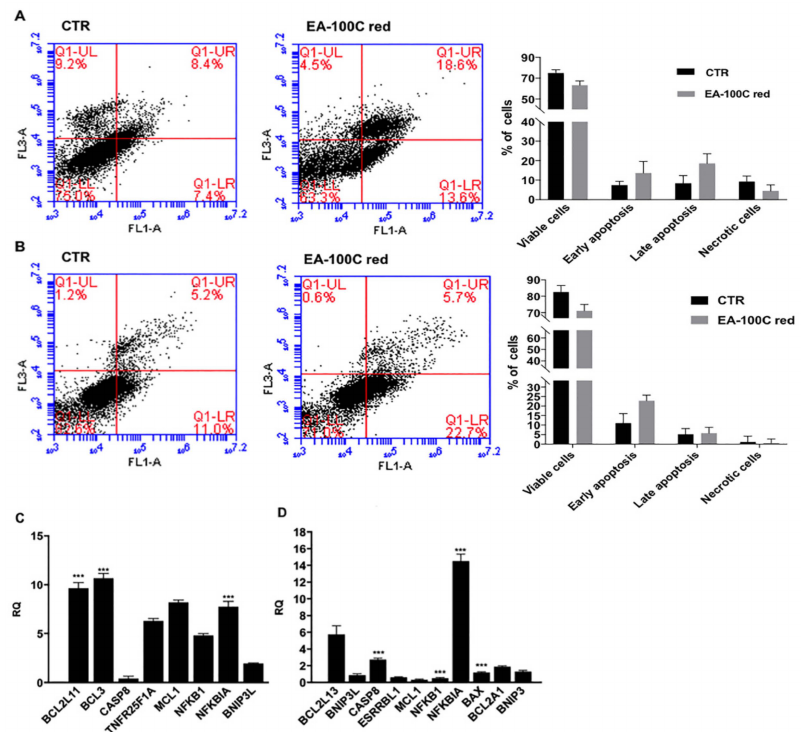
Figure 2. E ff ects of EA-100C red on apoptosis. (Left) U87MG ( A ) and LN229 ( B ) were not treated or treated with EA-100C red for 72 h at concentrations equal to IC 50 . Apoptosis was evaluated by FACS analysis, after double labeling with propidium iodide (PI) and FITC-Annexin V. The lower left quadrants of each panel show the viable cells, which exclude PI and are negative for FITC-Annexin V binding. The upper left quadrants contain the non-viable, necrotic cells, negative for FITC-Annexin V binding and positive for PI uptake. The lower right quadrants represent cells in early apoptosis that are FITC-Annexin V positive and PI negative. The upper right quadrants represent the cells in late apoptosis, positive for both FITC-Annexin V binding and for PI uptake. The experiments were performed at least three times and the results were always similar. (Right) Analysis of the expression levels of apoptotic genes by qRT-PCR reported as relative quantification (RQ) = 2 − ∆∆ Ct . Total RNA from U87MG ( C ) and LN229 ( D ) treated with EA-100C red for 72 h. Each experiment was repeated at least three times and data are shown as mean ± SD. *** p ≤